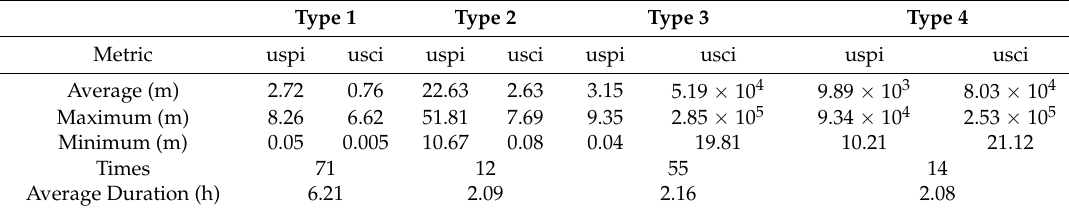
Table 2. Statistics of different types of unhealthy states lasting more than one hour.